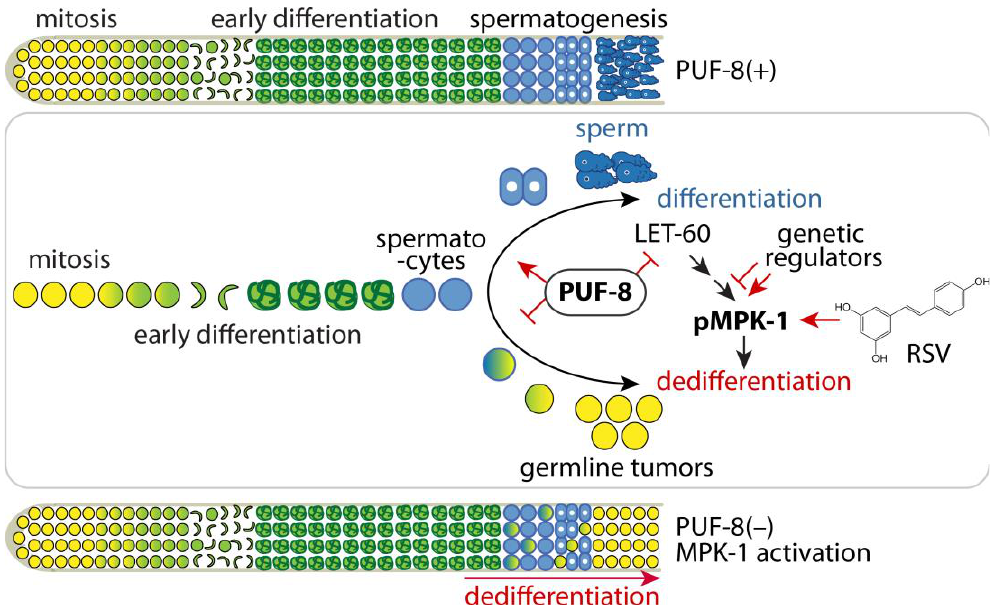
Figure 6. A model for the spermatocyte differentiation/dedifferentiation decision. Top: The schematic of normal spermatogenesis in the C. elegans germline. Middle: Genetic and chemical regulation of the spermatocyte differentiation/dedifferentiation decision. Bottom: Schematic of spermatocyte dedifferentiation-mediated tumorigenesis via PUF-8 loss and activation of MPK-1 signaling.